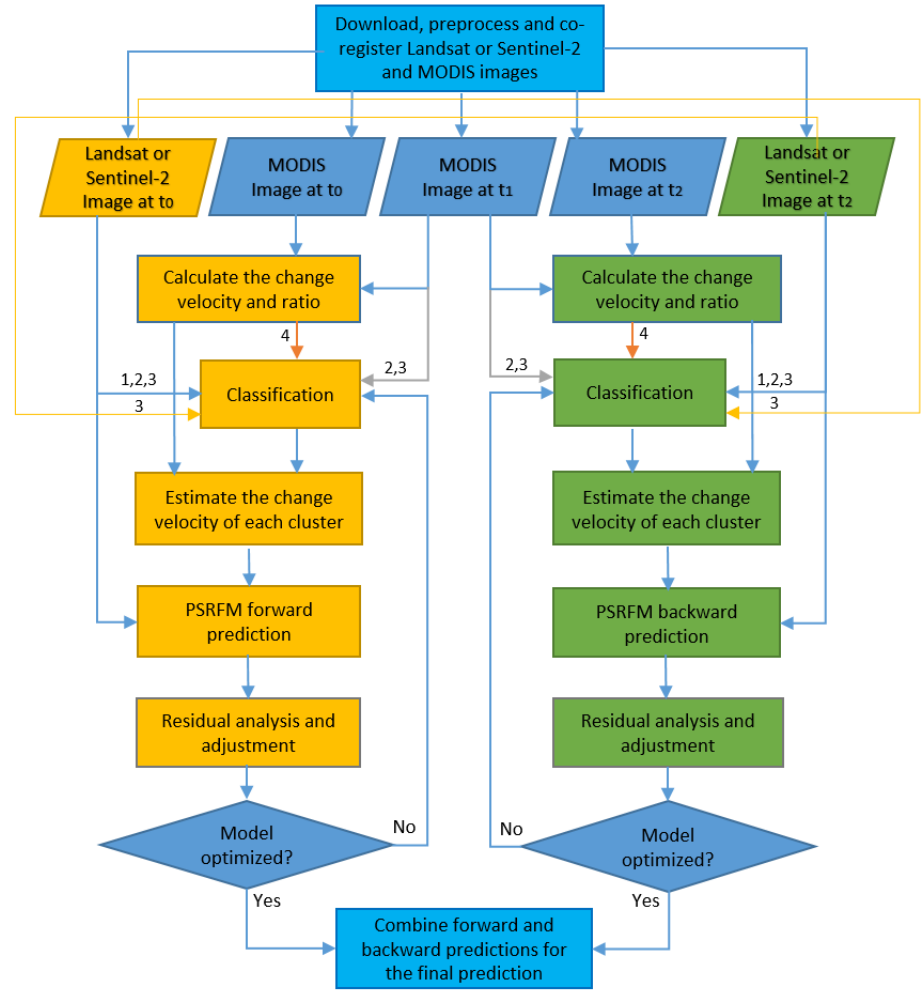
Figure 1. Processing flowchart of the improved Prediction Smooth Reflectance Fusion Model (PSRFM). The numbers 1 to 4 around the box classification mean the different input data for the methods CLUSTER- i ( i = 1, 2, 3, 4).